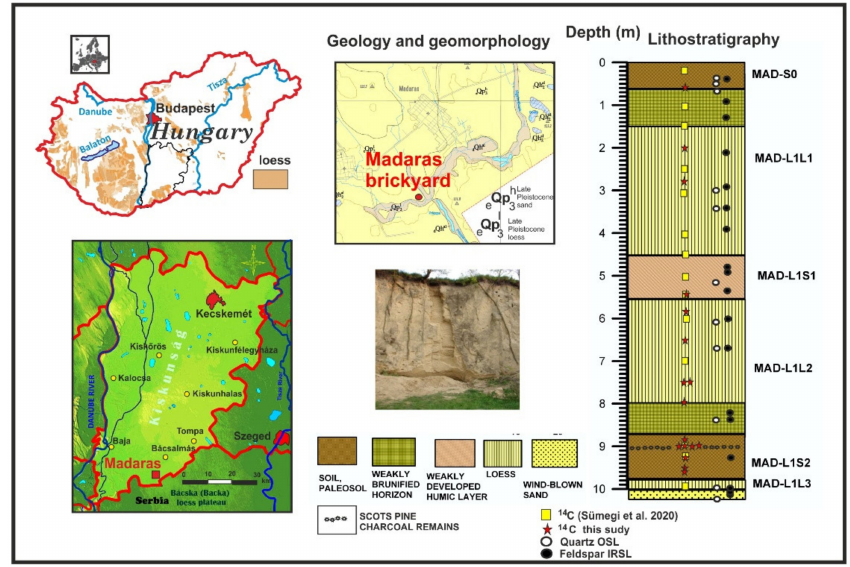
Figure 1. Location, lithostratigraphy of the studied loess/paleosol sequence of Madaras brickyard with sampling points for 14 C [5] AMS, quartz OSL and polymineral pIRIRSL